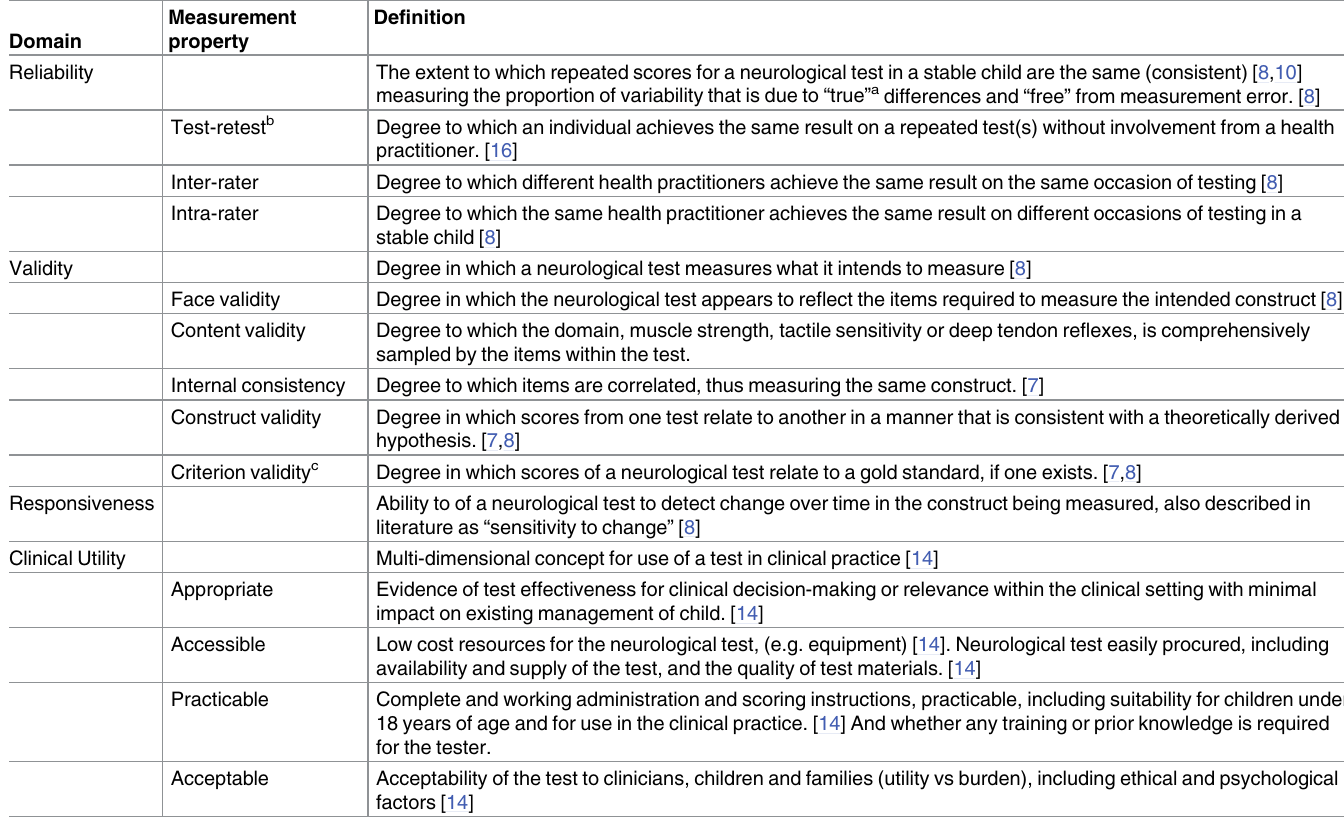
Table 1. Clinimetric definitions for a lower limb neurological impairment